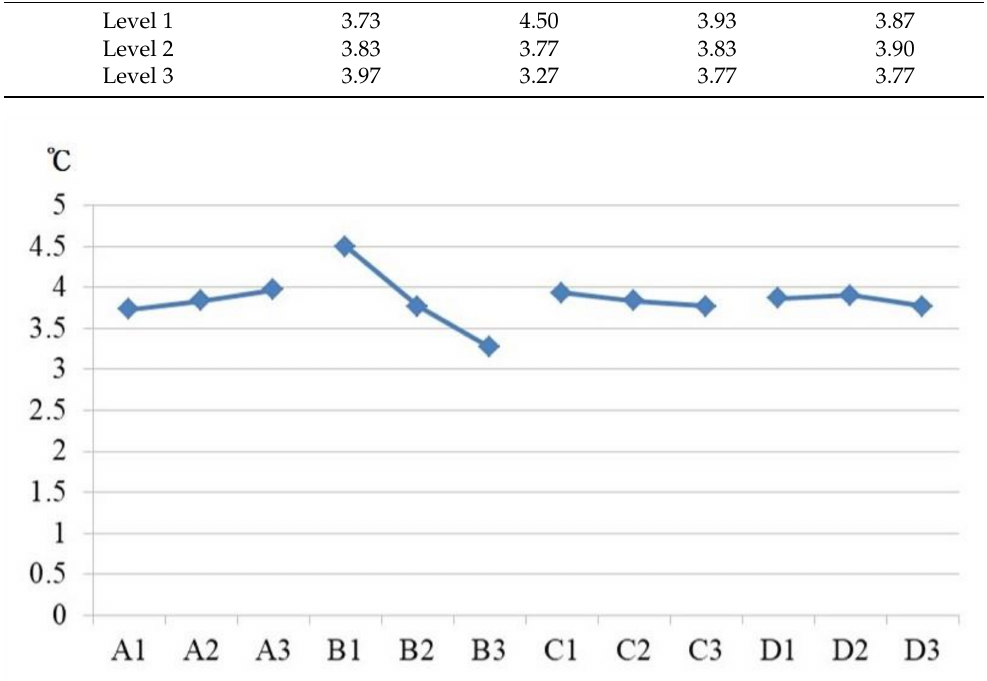
Figure 10. Average temperature quality response